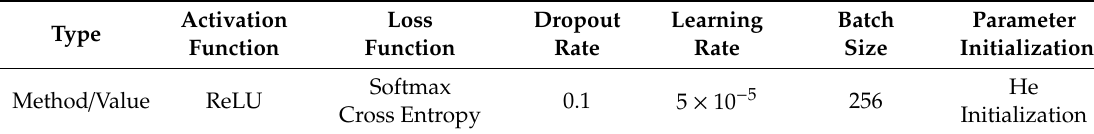
Figure 8. The network structure of OSCNet. Table 6. Attributes and hyperparameters of OSCNet.